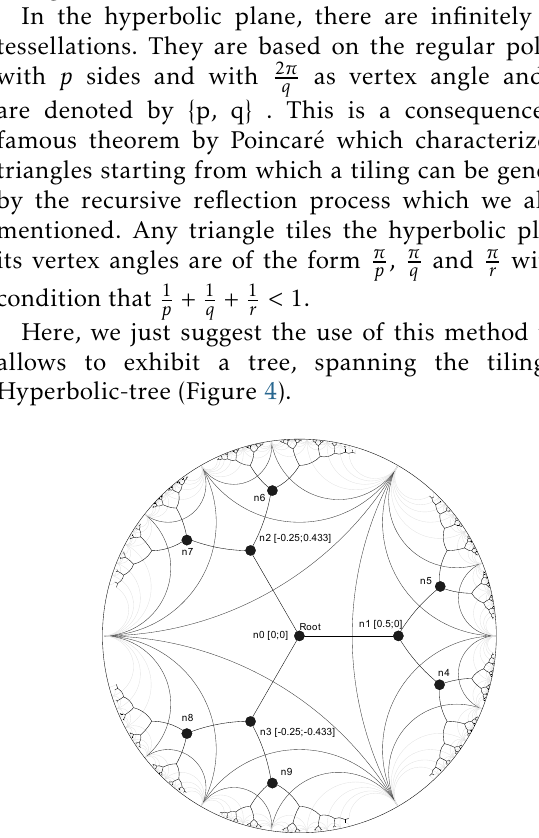
Figure 4. 3-regular tree in the hyperbolic